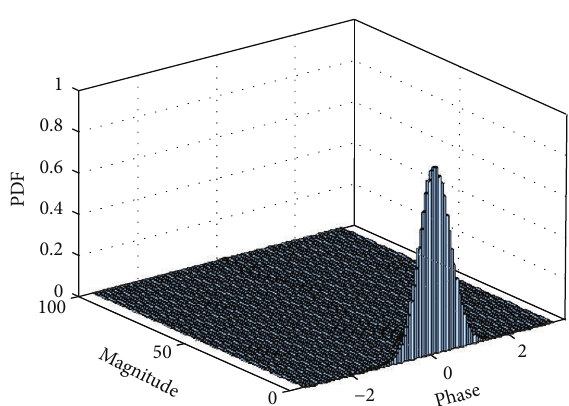
Figure 4: The three-dimension histogram of the tested urban area. Second, via (14) and (16), the estimate ̂𝛾 of the parameter 𝛾 is